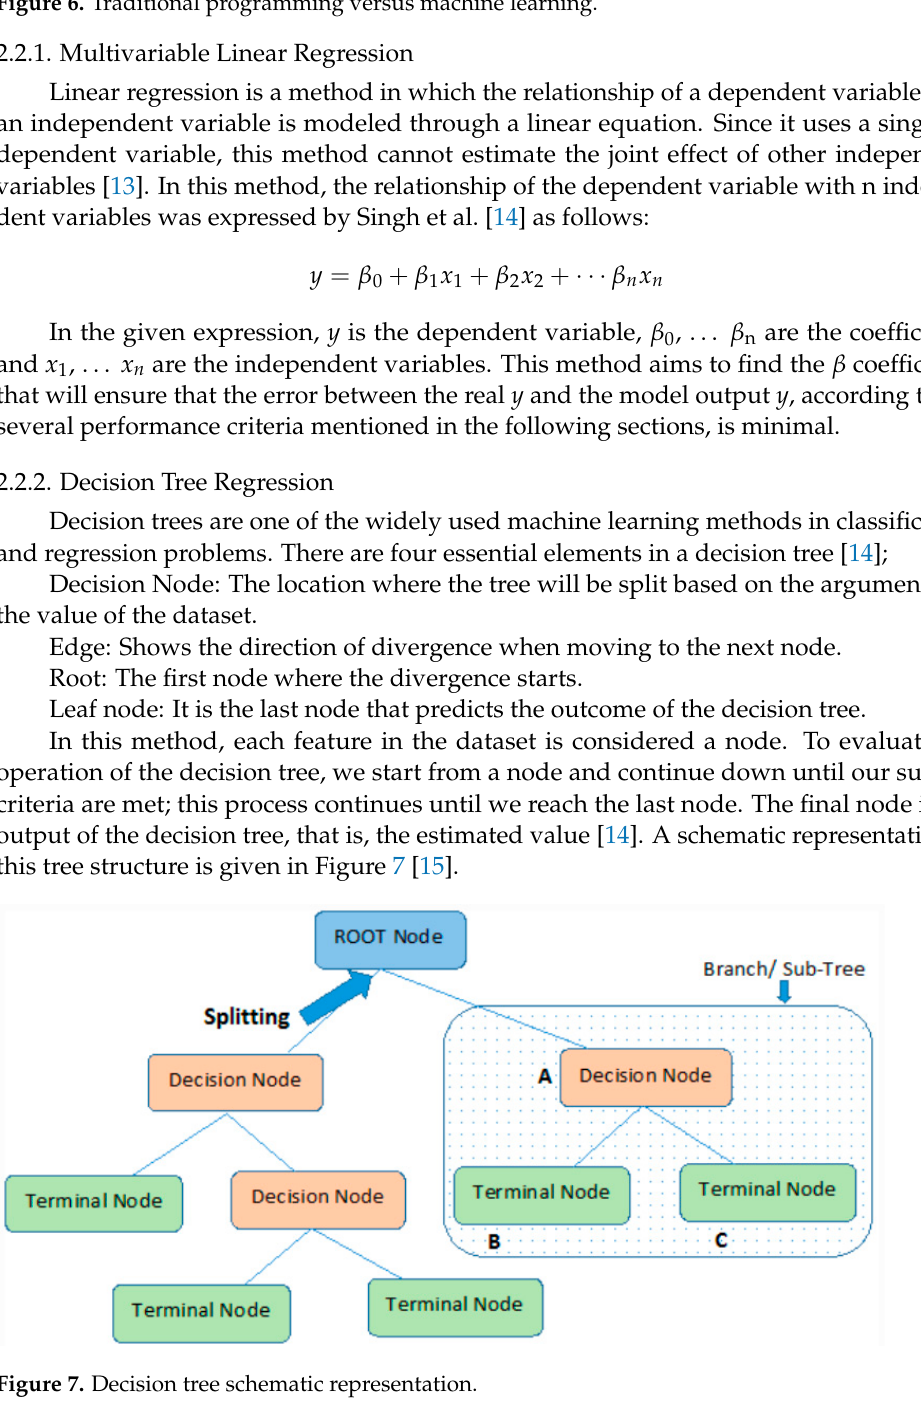
Figure 6. Traditional programming versus machine learning.